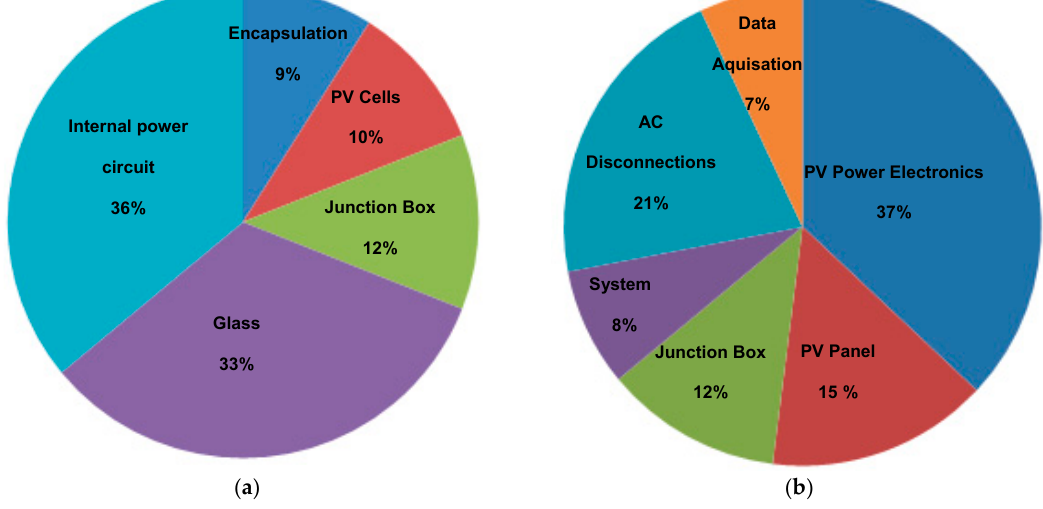
Figure 1. Failures in photovoltaic (PV) systems: ( a ) failure distribution [2]; and ( b ) unscheduled maintenance events [4].